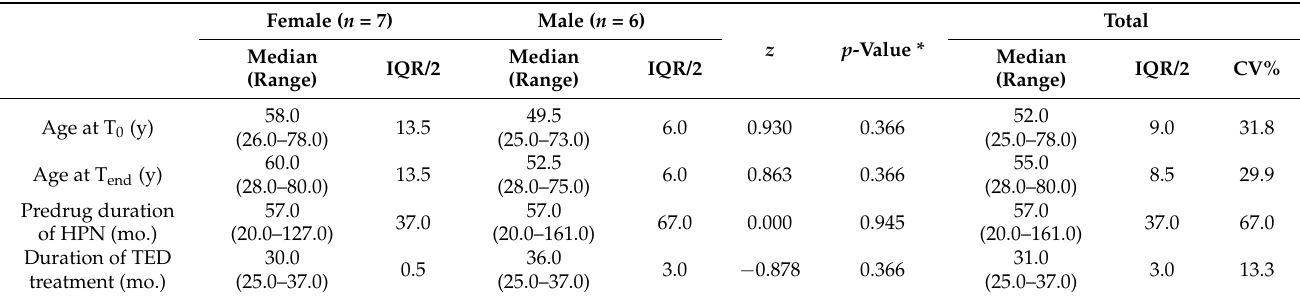
Table 1. Characteristics of the study group.